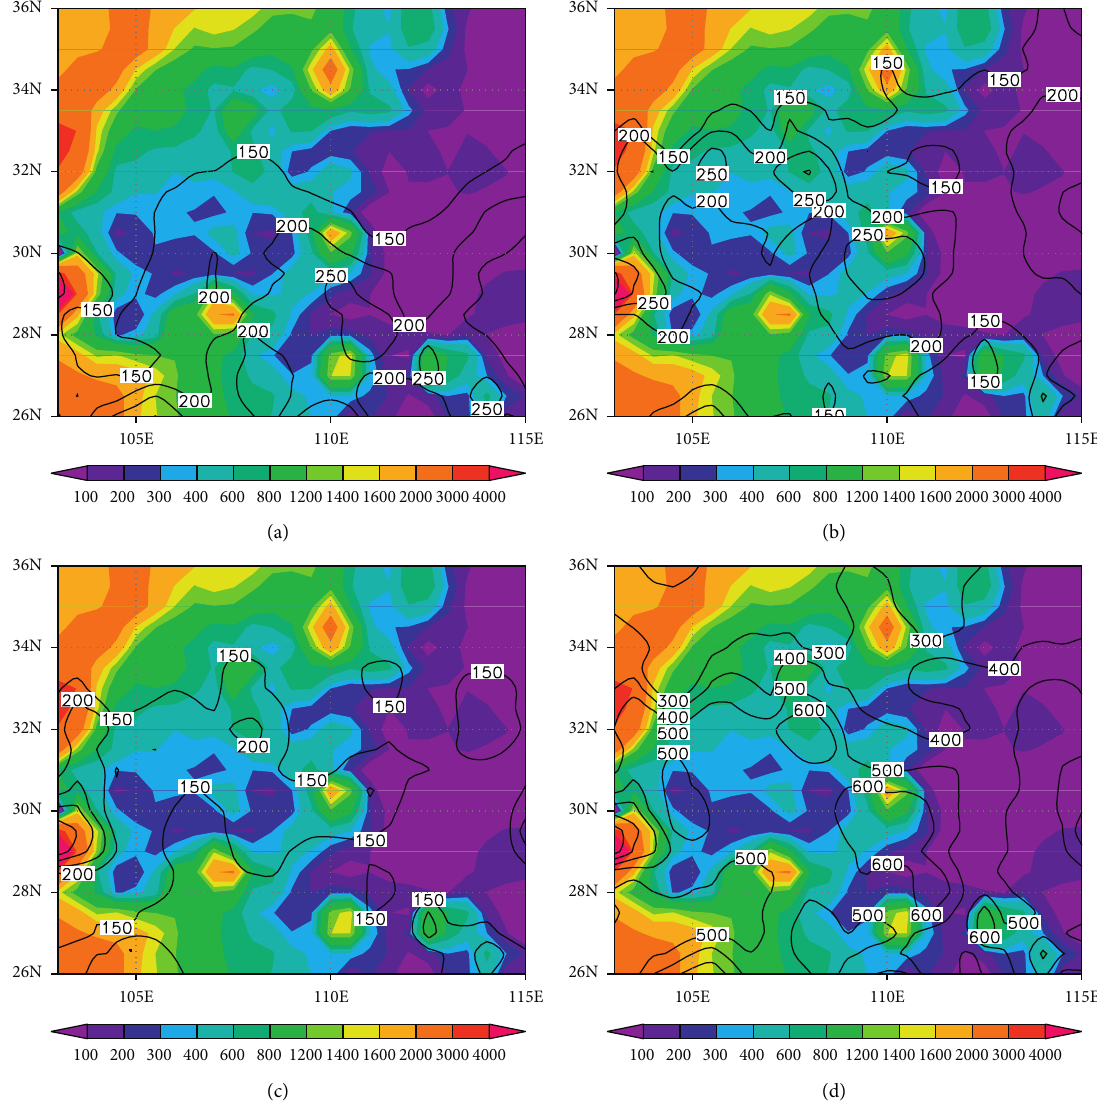
Figure 3: Distribution of rainfall amount in (a) June, (b) July, (c) August, and (d) summer (contours, units: mm) averaged from 1979 to 2008. The rainfall contours larger than 150mm are drawn. The shaded area denotes the altitude (units: